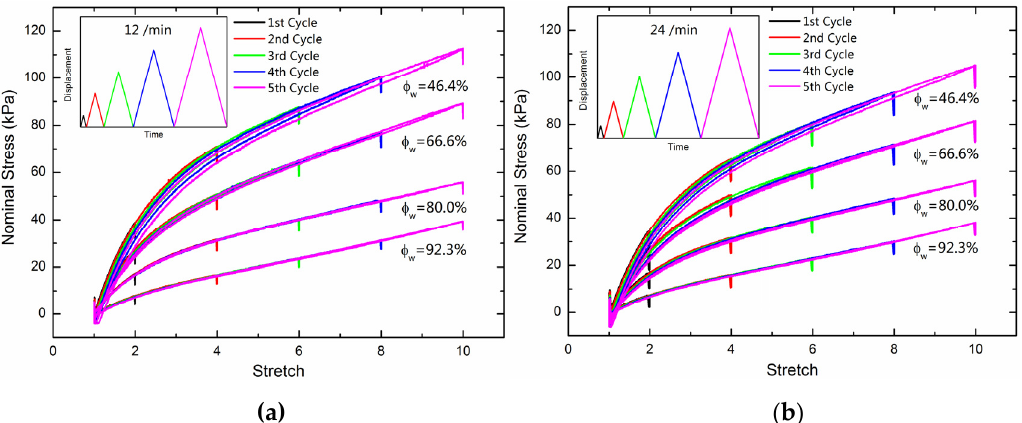
Figure 3. ( a ) Nominal stress ‐ stretch curves for the cycling loading of PAAm hydrogels with different water content at the loading rate of 12/min; ( b ) Nominal stress ‐ stretch curves for the cycling loading of PAAm hydrogels with different water contents at the loading rate of 24/min.